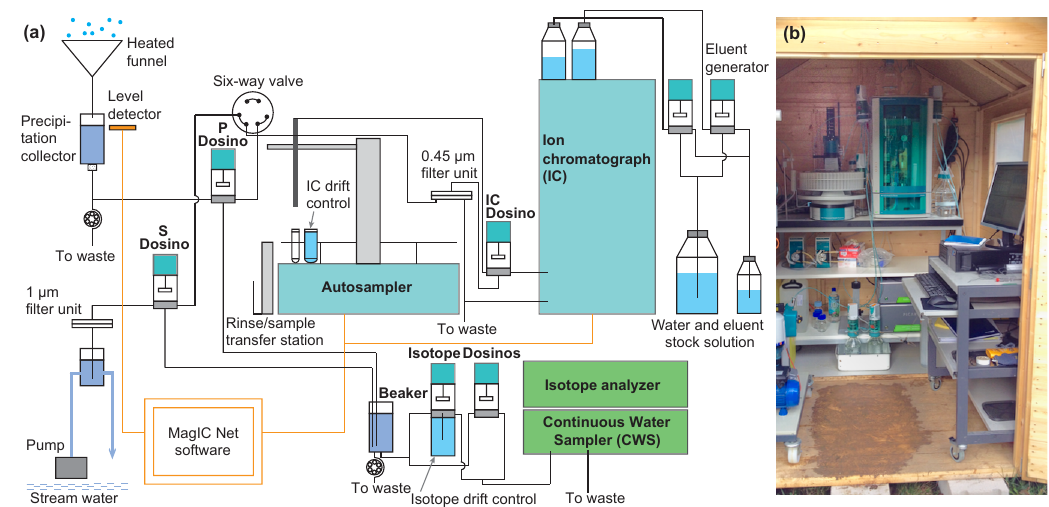
Figure 1. (a) Schematic overview of the coupled isotope analyzer/IC system for the collection and analysis of stream water and precipitation samples. The components of the sample distribution and the IC are shown in blue, while the isotope analyzer with the CWS is shown in green. Panel (b) shows a photo of the coupled isotope analyzer/IC system in the wooden hut during the field